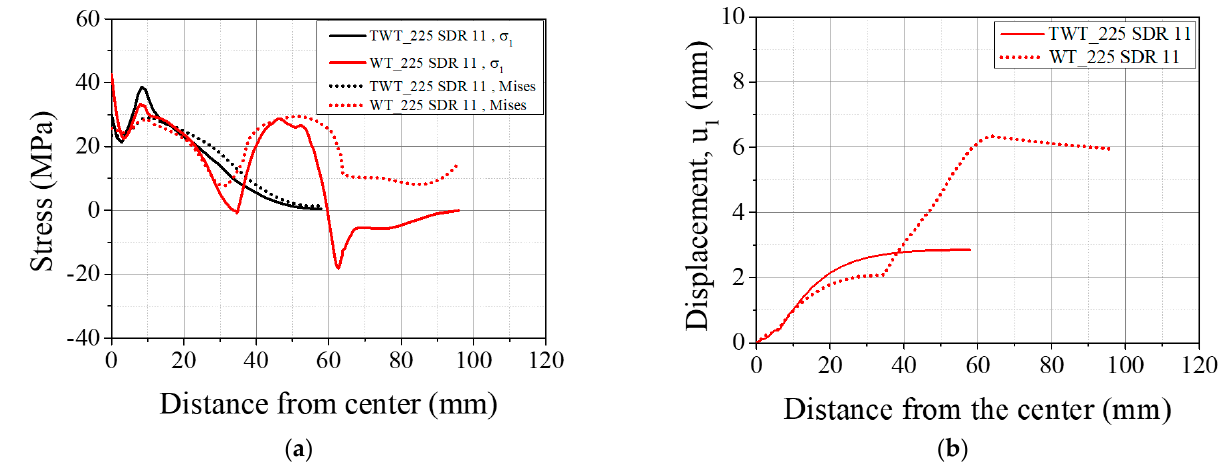
(cid:3049) and 𝜎 (cid:2869) ; ( b ) 𝑢 (cid:2869)